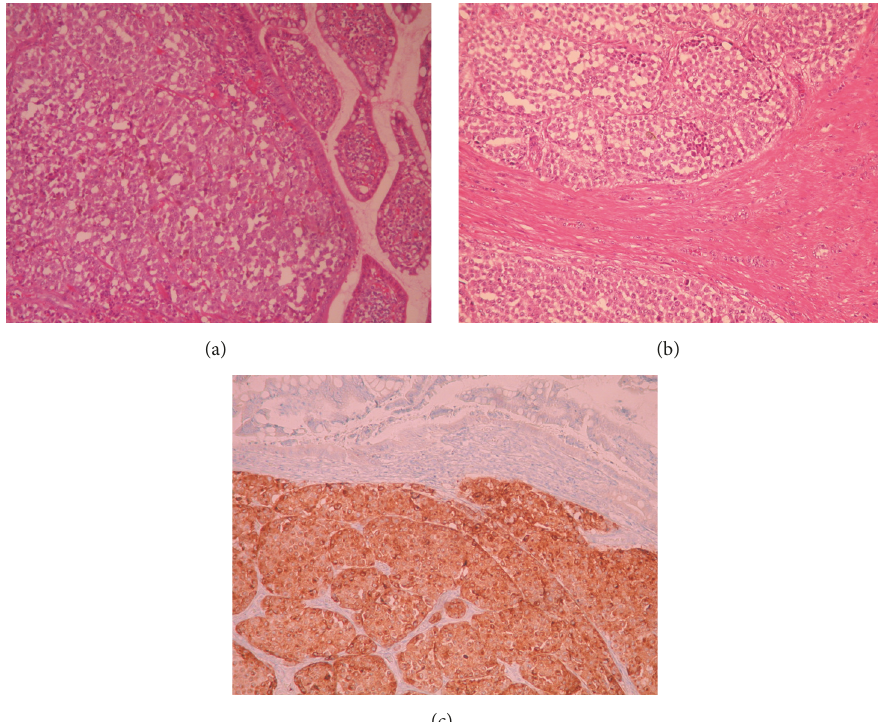
Figure 2: (a) Invasion of the mucosa of the small intestine by the melanoma cells (H+EX200). (b) Invasion of the muscularis propria by the melanoma cells (H+EX100). (c) Tumor cells are positive for HMB45 (immunostain ×